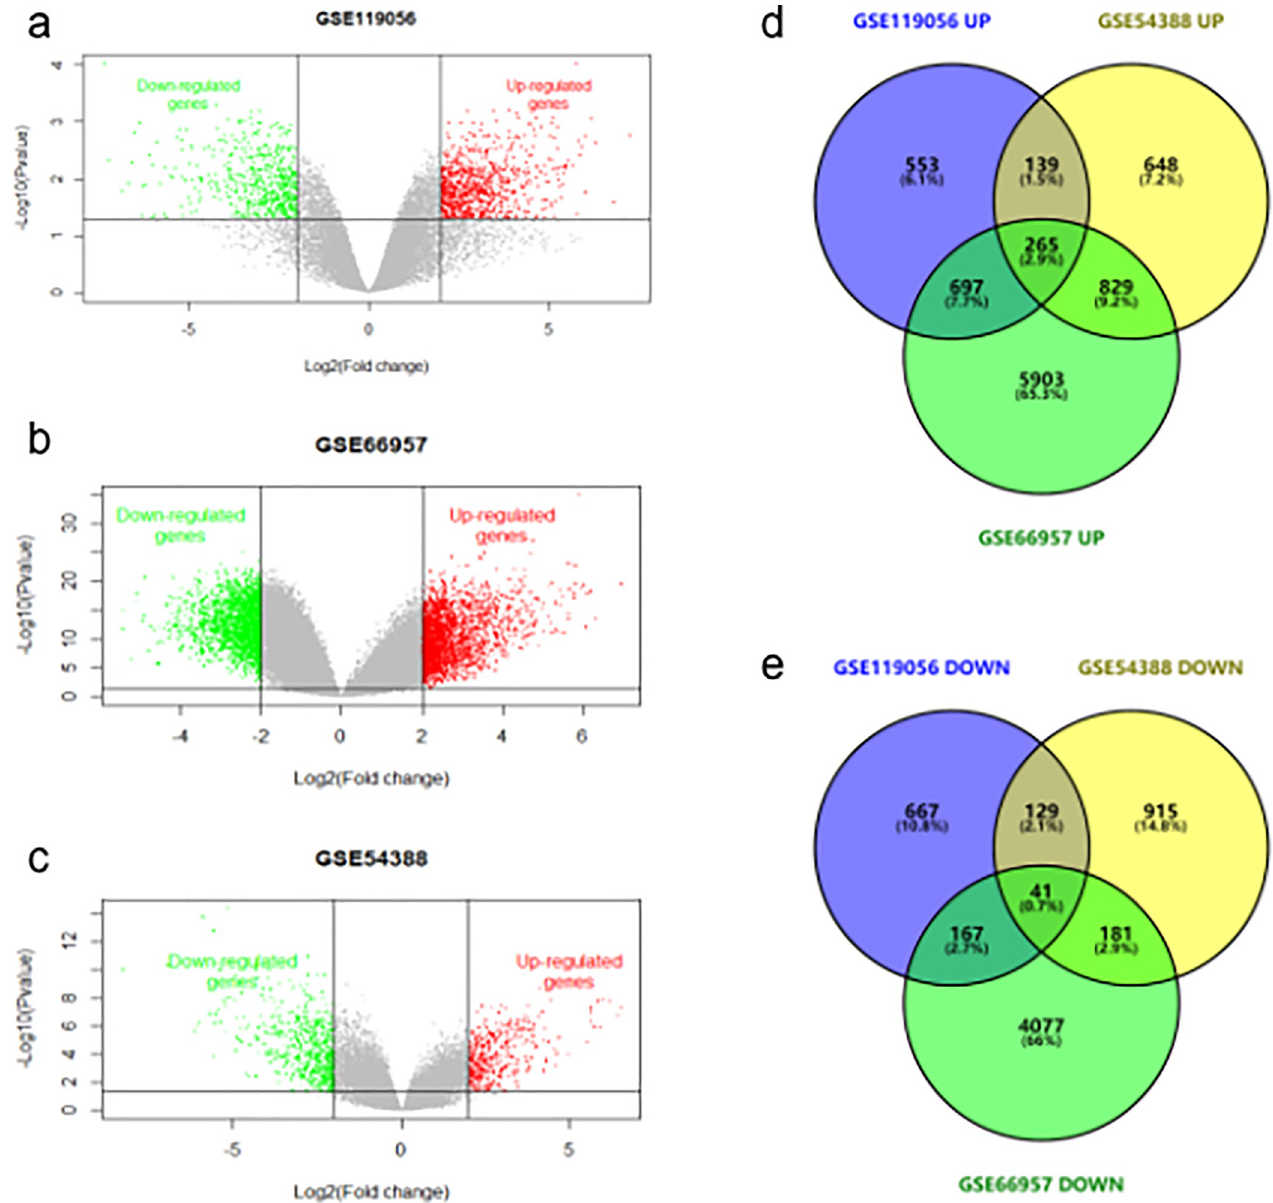
Fig 1. Identification of differentially expressed genes (DEGs) in three gene expression omnibus (GEO) datasets. (a) Volcano plot of DEGs in GSE119056. (b) Volcano plot of DEGs in GSE54388. (c) Volcano plot of DEGs in GSE66957. Red, blue and gray color represent relatively high, low and equal expression of genes in the corresponding group, respectively. (d) Venn diagram of 265 overlapping up-regulated genes from intersection of three independent GEO datasets. p < 0.05 and |log FC | > 1 were set as the threshold. (e) Venn diagram of 41 overlapping down-regulated genes from intersection of three independent GEO datasets. p < 0.05 and |log FC | > 2 were set as the